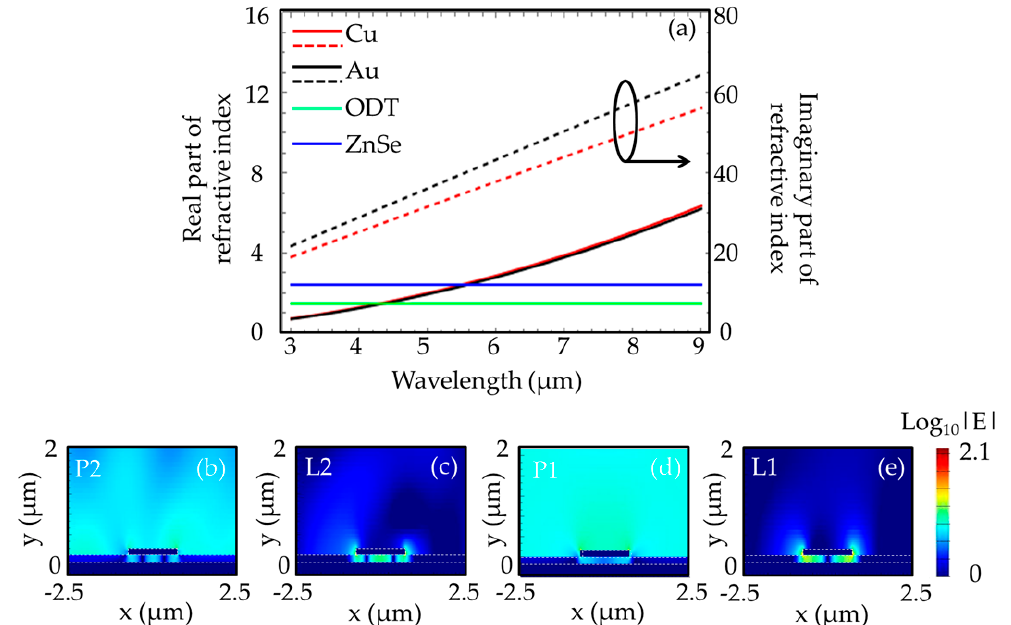
Figure 5. ( a ) Refractive indices of the relevant materials used in simulation. Spatial field distributions for propagating surface plasmon resonances (PSPs), i.e., ( b ) P2 with mode number m = − 2, ( d ) P1 with mode number m = − 1, and local surface plasmon resonances (LSPRs), i.e., ( c ) L2 with mode number L = 2, ( e ) L1 with mode number L = 1. Table 3. Simulated wavelength shift values of local surface plasmon resonances (LSPRs) and propagating surface plasmon resonances (PSPs) in the metagrating sample.